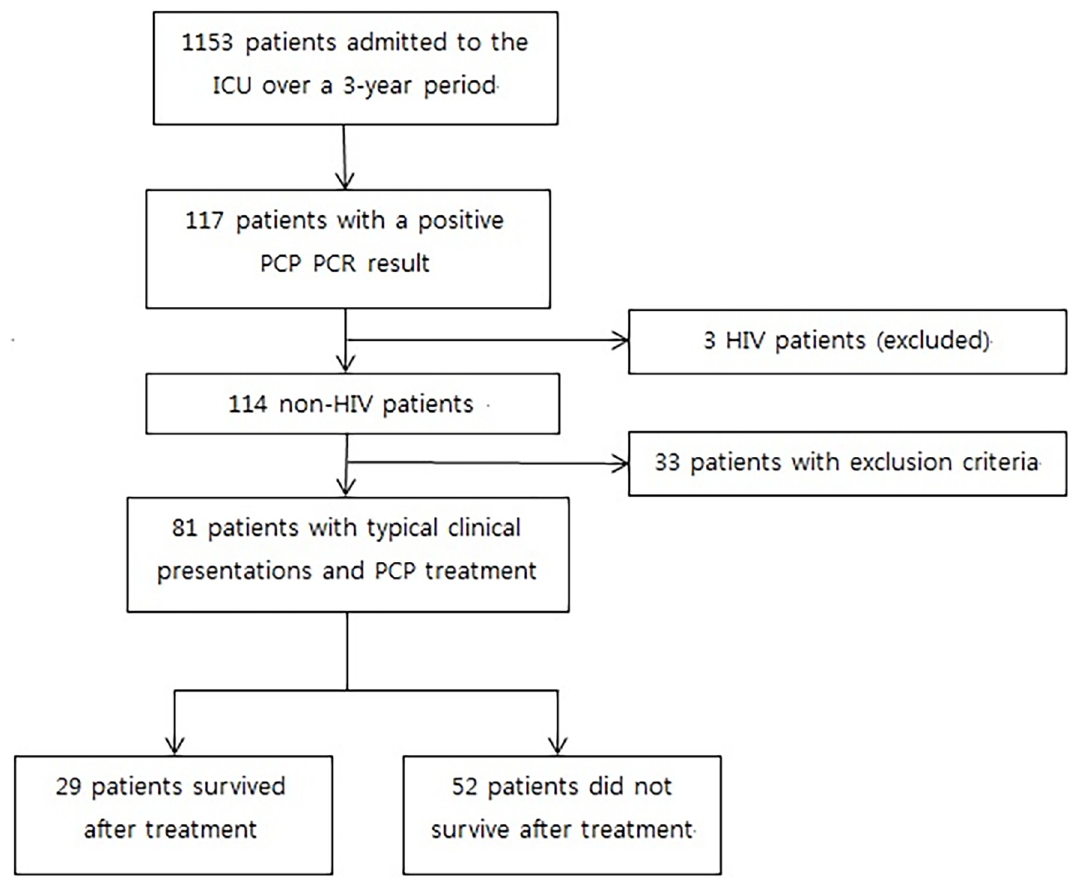
Fig 1. Flowchart showing patient selection. ICU, intensive care unit; PCP, Pneumocystis jirovecii pneumonia; PCR, polymerase chain reaction; HIV, human immunodeficiency